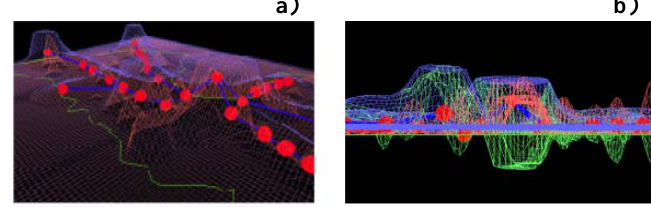
Fig. 3. The result of visualization of Latvia railways in the GIS framework Image „a)” provides the unified visual representation of { Stations , Roads , Attributes } data arrays (the capacity of existing Latvian railway infrastructure is marked with blue colour, the population in certain region – with red). In turn, the result in the image „b)” enhances the result by providing supplementary visual heightmap (green) that represents the difference of these two data arrays in certain area of region and can be used for convenient identification of regions, where the expansion of the infrastructure is